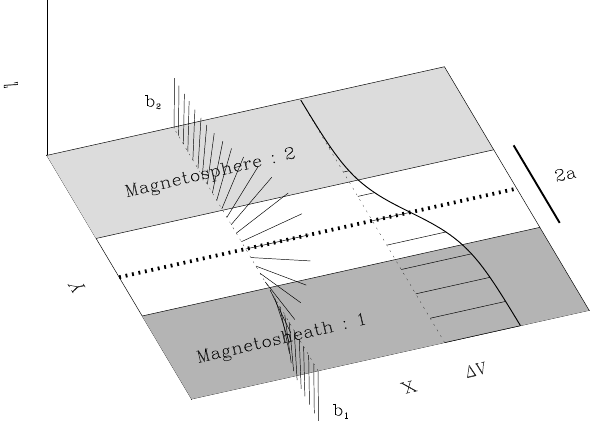
Fig. 1. The available TEC observations at 350km altitude for a 15min